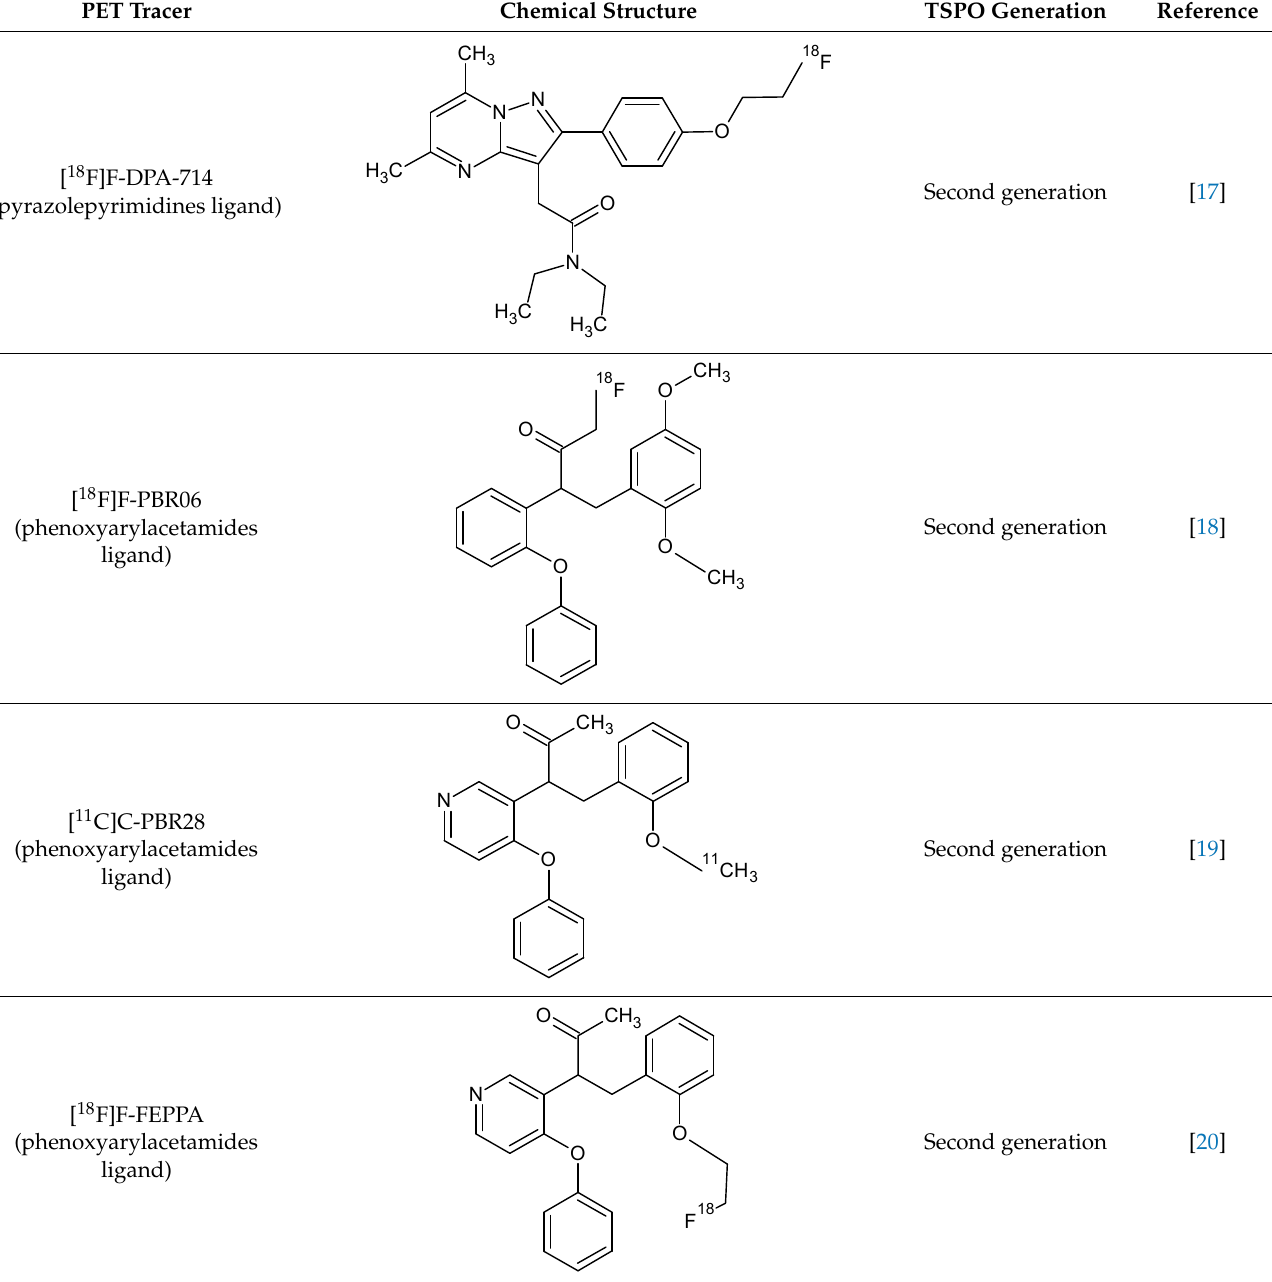
Figure 1. Reaction for [ 18 F]F-FETEM using GE Tracerlab FXFDG synthesis module in one step synthesis by classical [ 18 F]flu- oride nucleophilic substitution of the p-toluenesulfonyl precursor using potassium carbonate and Kryptofix ® 222 at 100 °C for 5 min.